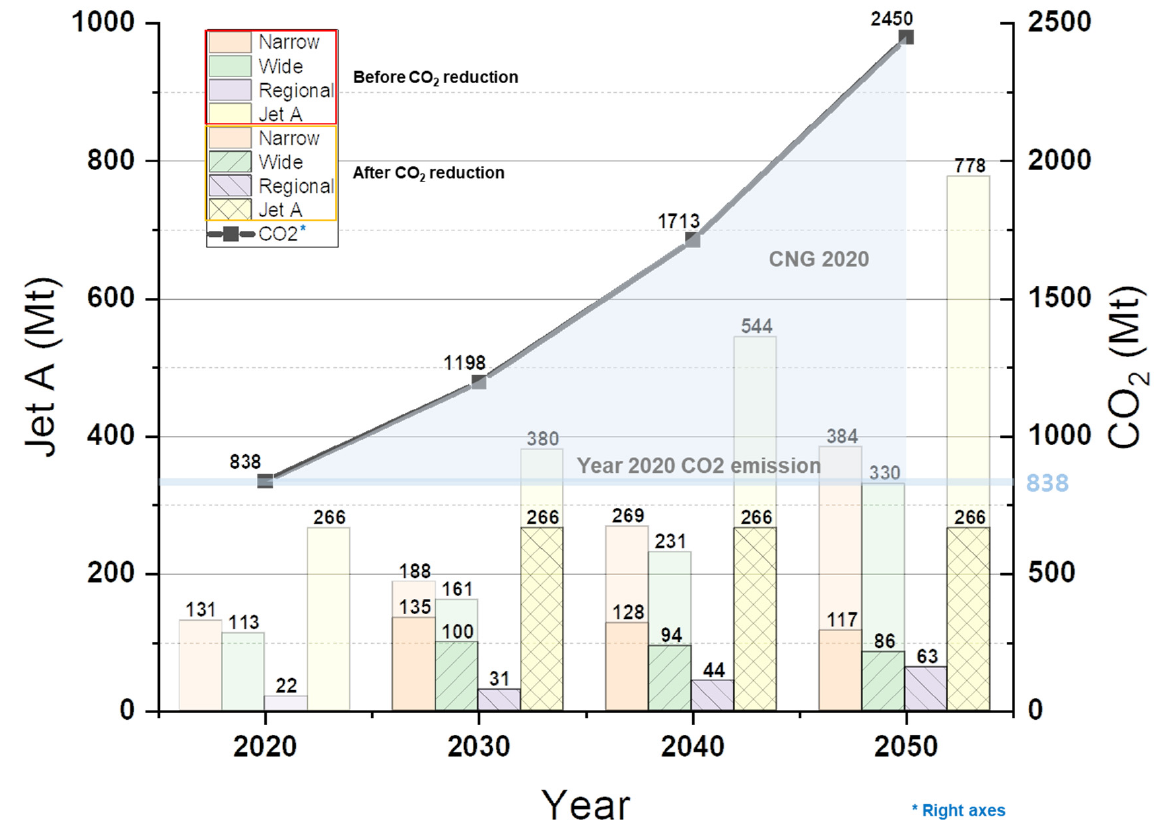
Figure 7. Total Jet A fuel conversion to LH 2 to meet CNG 2020.